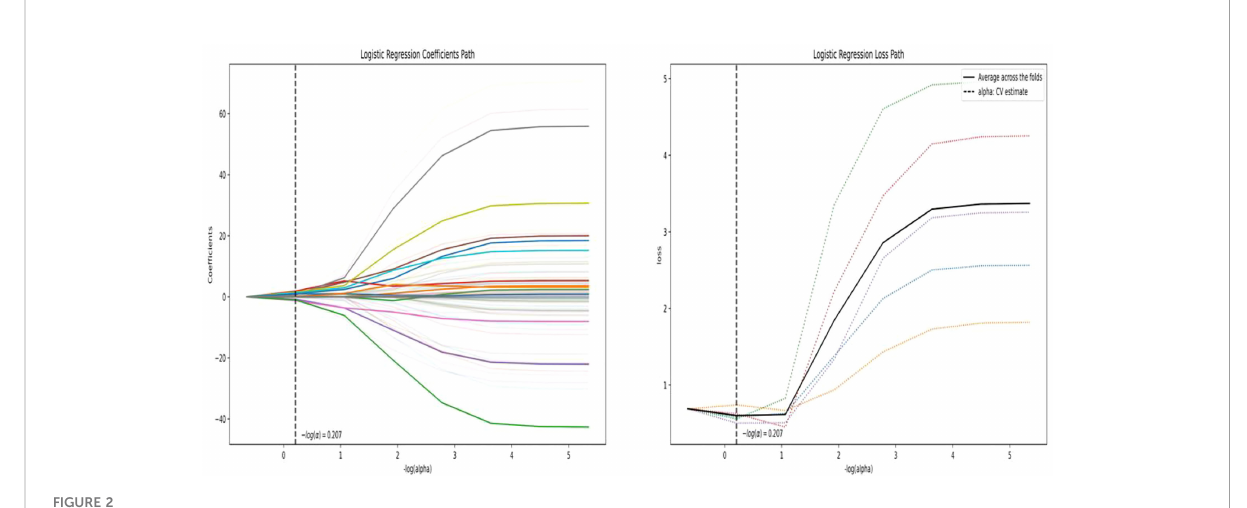
FIGURE 2 ASSO algorithm for feature selection. LASSO path (left); MSE path